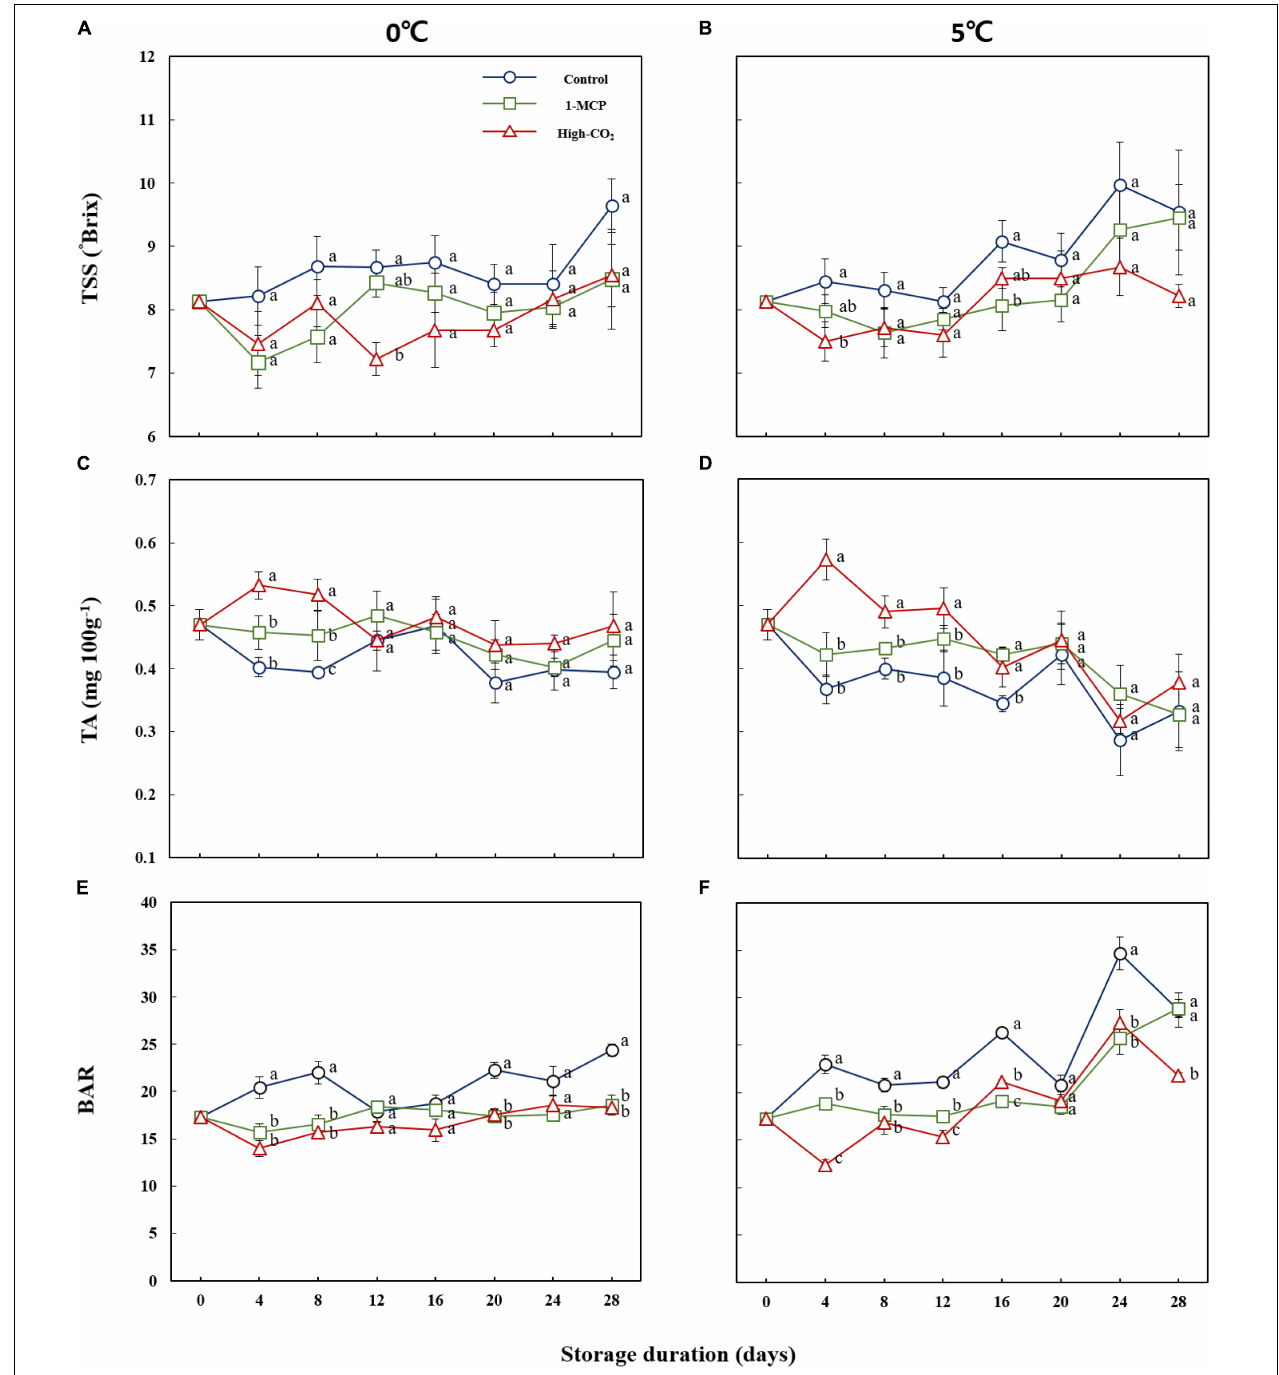
FIGURE 3 | The TSS (A,B) , TA (C,D) , and BAR (E,F) of Madoka peach fruit at harvest and during storage up to 28 days at 0 and 5 ◦ C with or without prestorage treatment of CO2 and 1-MCP.